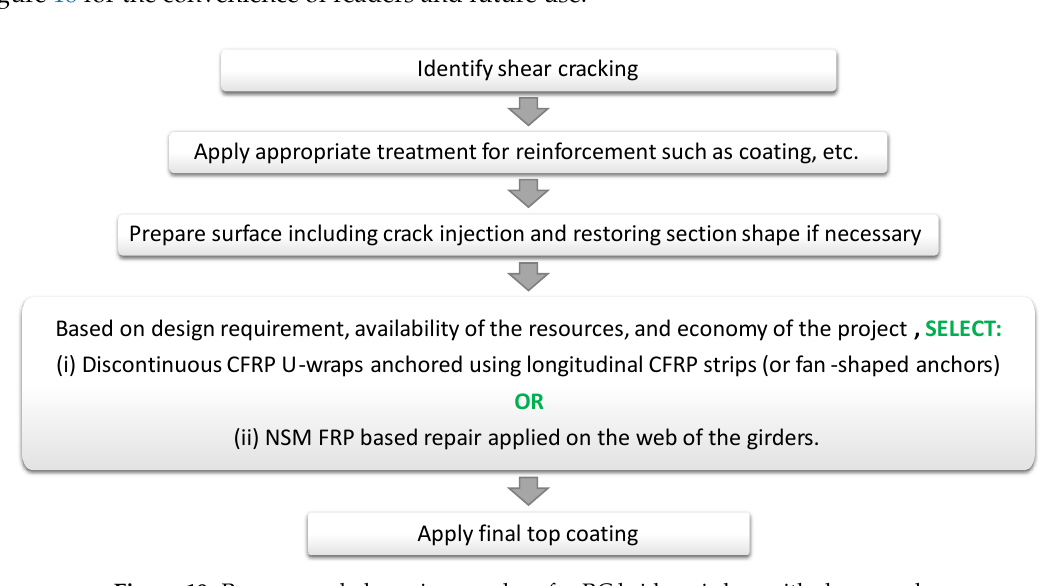
Figure 18. Recommended repair procedure for RC bridge girders with shear cracks.